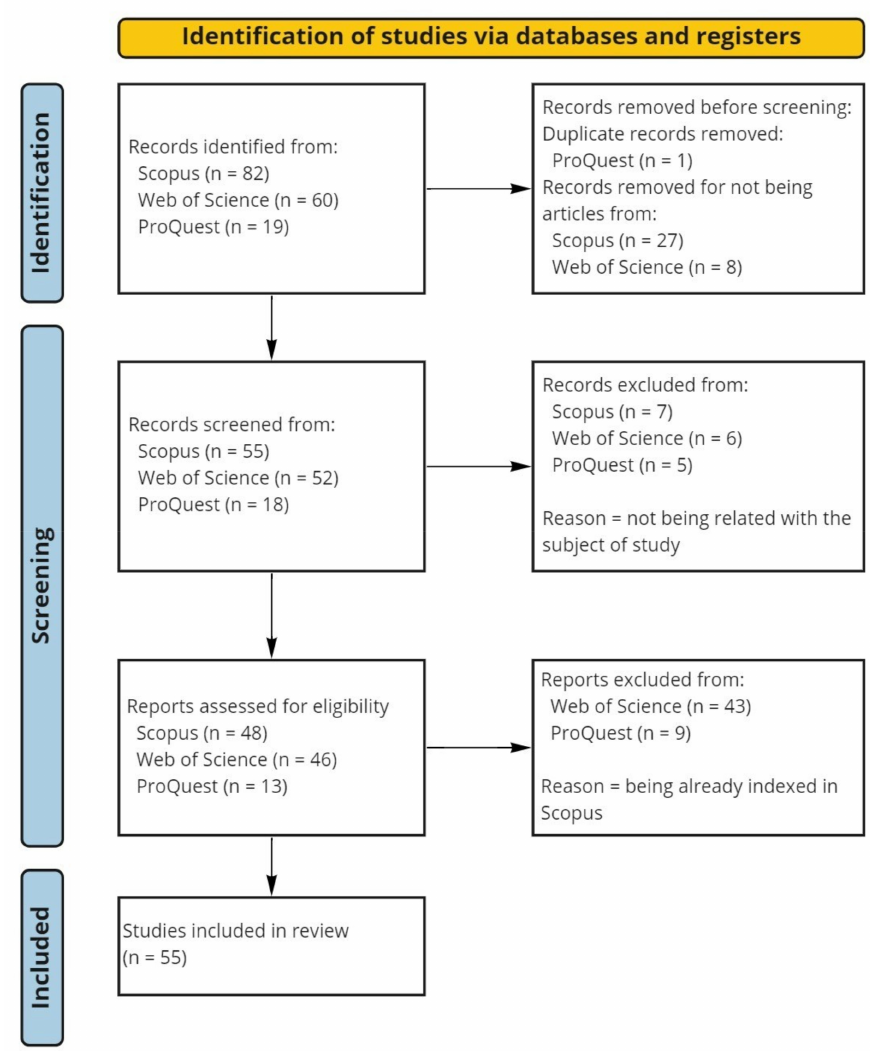
Figure 3. PRISMA flow